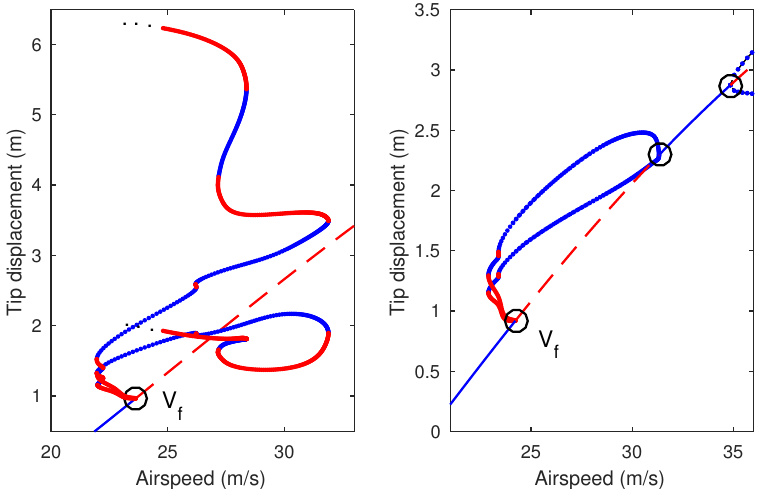
Figure 16. One-parameter continuation of equilibria and LCOs for varying airspeed for 10% K ( left ) and 15% K ( right